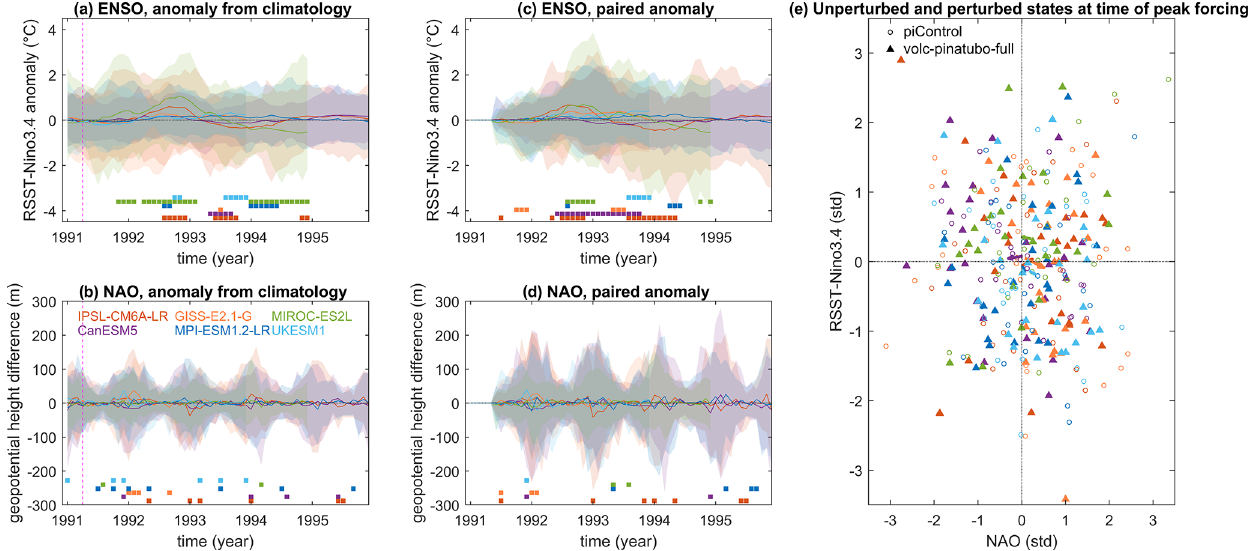
Figure 9. ENSO (RSST-Niño3.4 index) and NAO anomalies in the volc-pinatubo-full multi-model ensemble. (a–d) Anomalies for the indices calculated according to the VolMIP protocol as deviations from the unperturbed climatology (a, b) and as paired anomalies (c, d) . For each model, the shading illustrates the ensemble envelope, and the line indicates the ensemble mean. Squares at the bottom indicate when one model output is significantly different ( p < 0 . 05) from the others according to the Mann–Whitney U test. (e) scatterplots of standardized indices for the winter (DJF) season at the time of peak forcing in the volc-pinatubo-full. Shown are also corresponding values under unperturbed conditions following the VolMIP sampling protocol (see methods and Fig. 2). Arrows indicate ensemble mean changes between unperturbed and volcanically perturbed